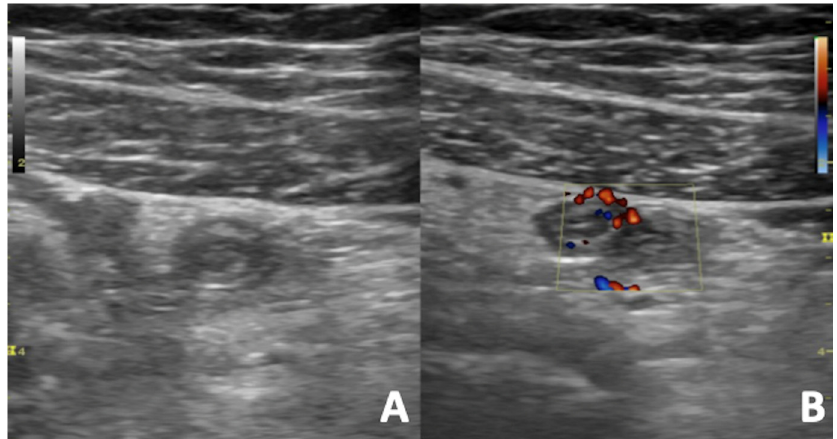
Figure 12. US B-mode ( A ) and Colour Doppler ( B ) scans of a pregnant woman with right iliac fossa pain. Acute appendicitis appears as aperistaltic, non-compressible and blind-ending tubular structure with thickened walls arising from the cecum. The surrounding fat is hyperechoic and inflamed. The color Doppler reveals an increased vascular flow of the appendix walls due to inflammation.